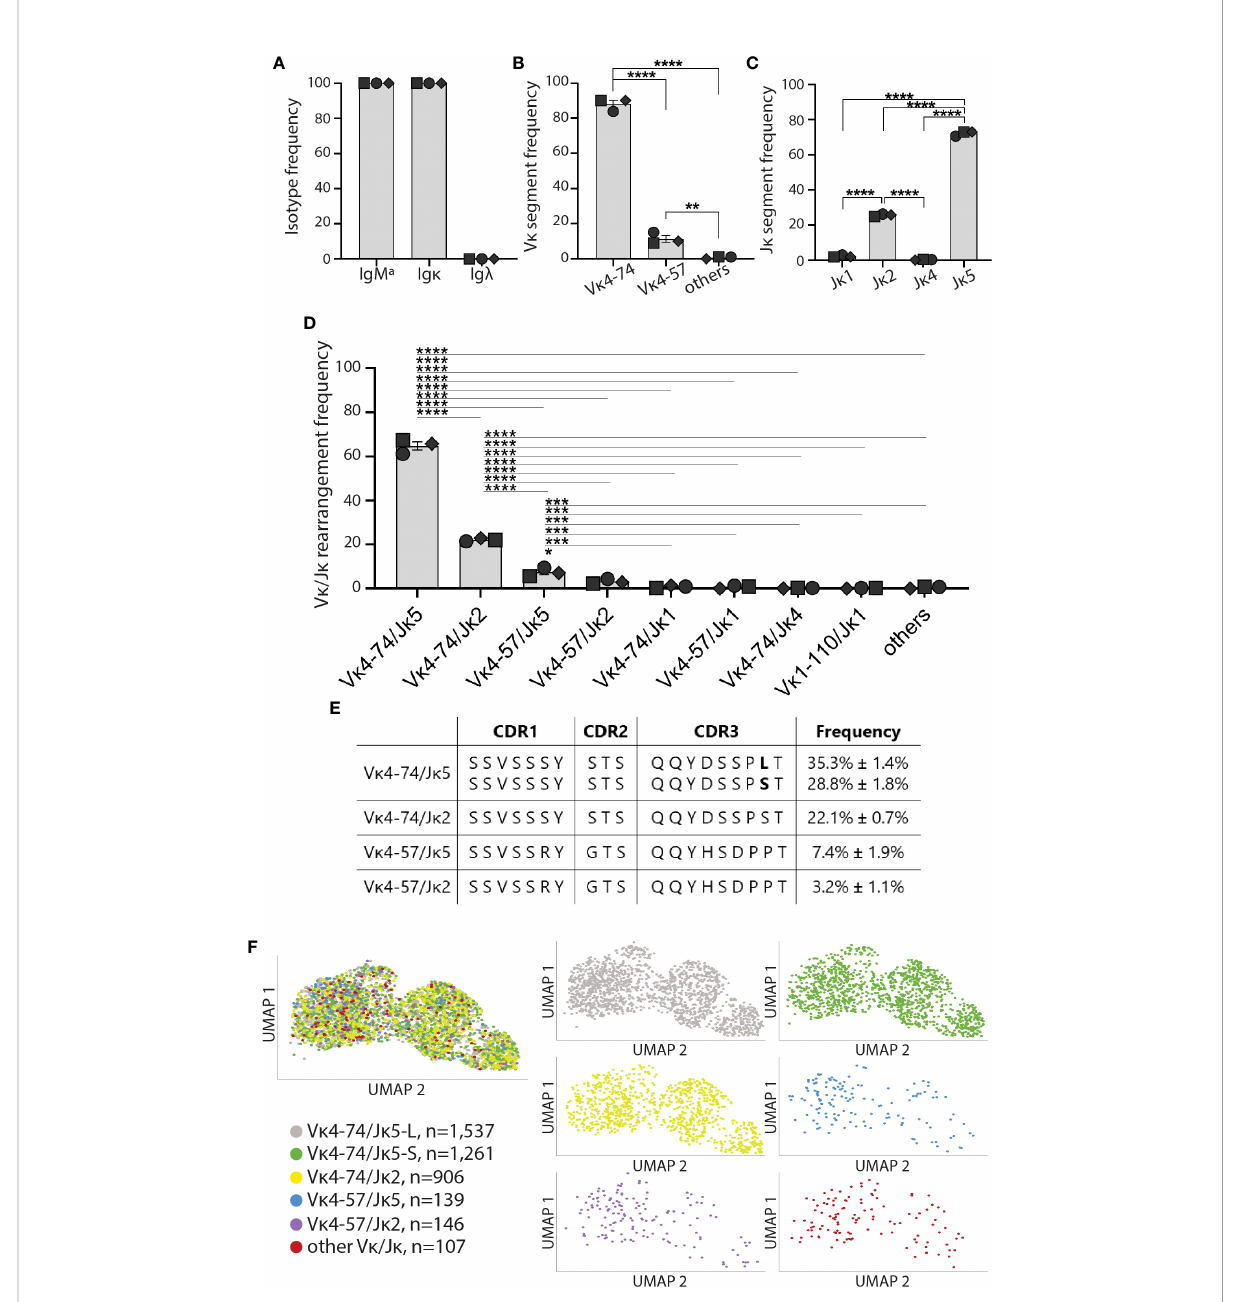
FIGURE 3 High-af fi nity IBCs of VH125.NOD expressed a biased Ig k repertoire. High-af fi nity IBCs from three prediabetic VH125.NOD mice from Figure 2 were additionally subjected to VDJ sequencing. (A) Heavy and light chain isotype frequency, (B) V k gene segment frequency, (C) J k gene segment frequency, (D) V k /J k gene rearrangement frequency among high-af fi nity IBCs (each symbol represents a mouse: circle – mouse 1, square – mouse 2, diamond – mouse 3). (E) Amino-acid composition in complementarity determining region (CDR) 1, 2, and 3 in the fi ve predominant light chains among high-af fi nity IBCs. (F) Distribution of fi ve predominant light chains on the UMAP gene expression (different colors representing fi ve predominant light chains, other V k /J k rearrangements were grouped and designated as “ other V k /J k ” ). One-way ANOVA, followed by post hoc Tukey ’ s multiple comparisons tests were used to determine the signi fi cance of differences among groups. *P < 0.05, **P < 0.005, ***P < 0.0005, ****P <